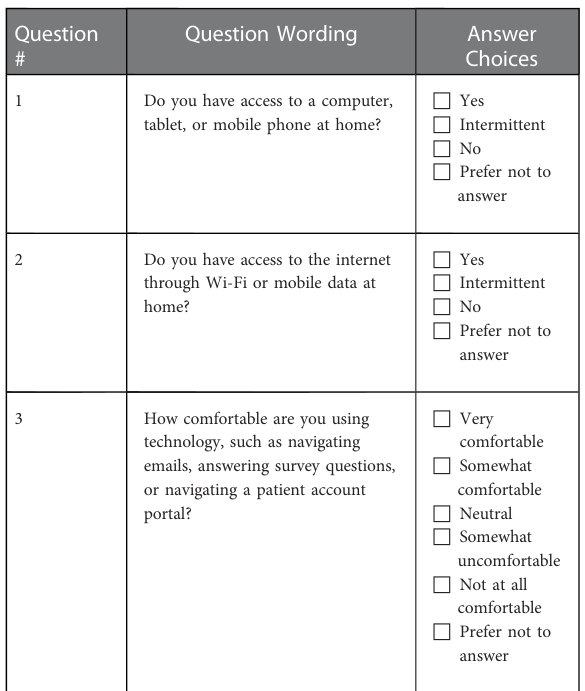
TABLE 4 Answer choices for the MCM technology access